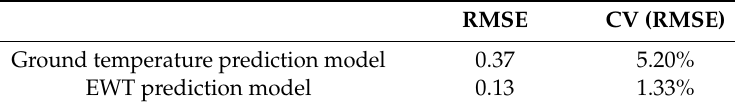
Table 5. Results of the error analysis.